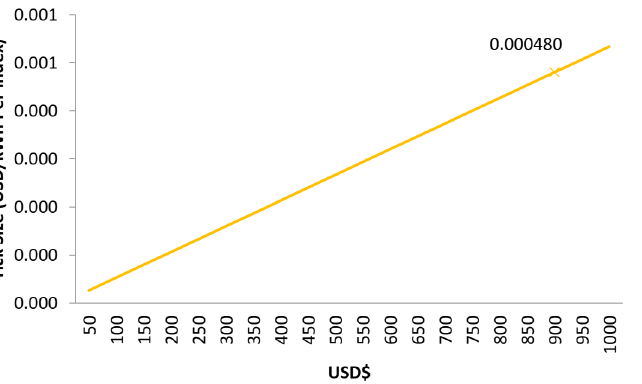
Figure 4. Tick size, depending on the monetary quantity in the case of the Almirante Padilla station. The strike index is calculated as the historical yearly average Nordix index for the summer season and has a value of 215.8. The tick value is calculated following Equation (3), taking a value of 125.4 as the Nordix barrier.